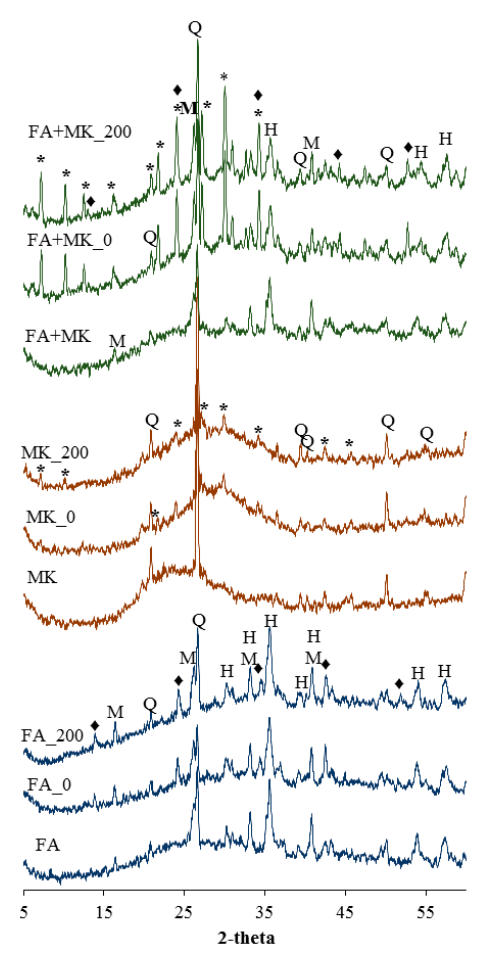
Figure 3. The compressive strength of pAAM on day 3 and day 10 (after seven days in water media).